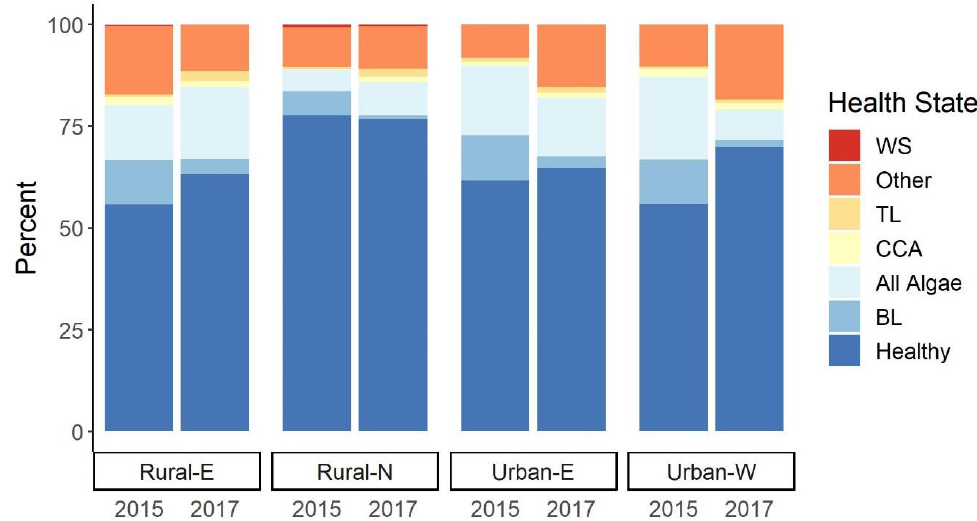
Figure 5. Prevalence of disease and states of compromised health on corals recorded in 15 × 2 m belt transect surveys at four sites (Rural-N, Rural-E, Urban-W, Urban-E), pooled by depth in Timor-Leste from November 2015 and June 2017. Abbreviations as follows: All Algae—combined macroalgae, turf, and cyanobacteria overgrowth; BL—Bleaching; CCA—Crustose coralline algae overgrowth; Other: combined pigmentation, predation, invertebrate infestation/overgrowth, burrowing invertebrates; TL—Unexplained tissue loss; WS—White Syndrome.